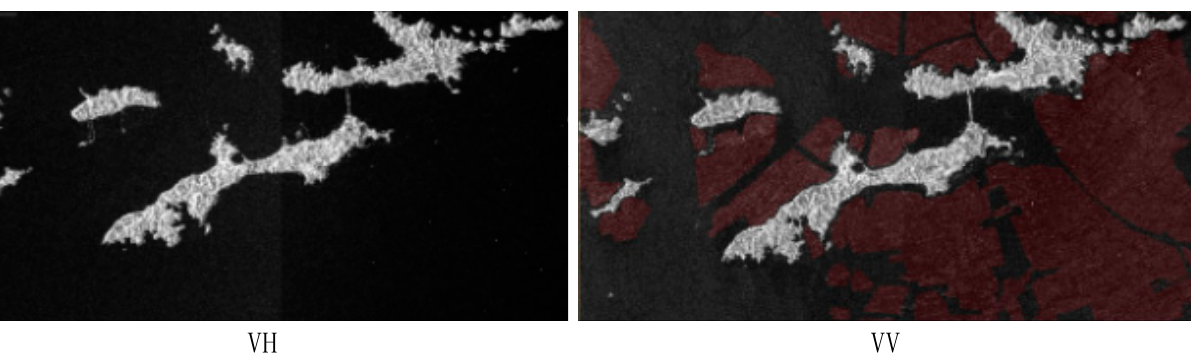
Figure 4. View of the Sentinel-1 dual polarization image.